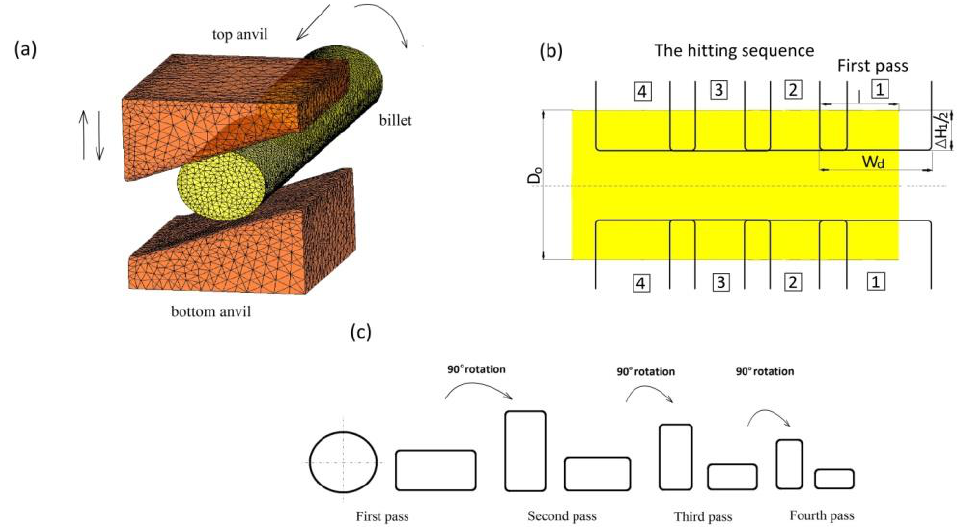
Figure 4. Schematic illustration of the cogging process: ( a ) finite element model for the forging experiment; ( b ) the hitting sequence for the cogging process ( l / w d = 0.70; l / D 0 = 0.75); ( c ) pass sequence for the cogging process.